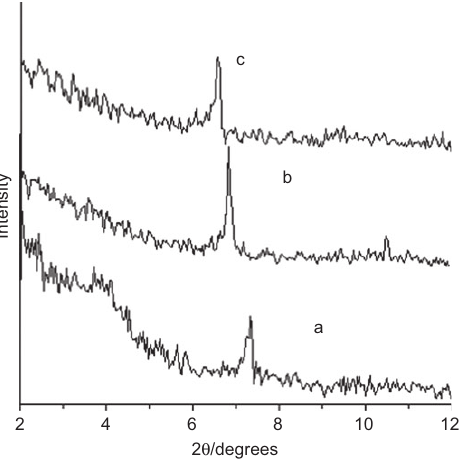
Figure 9 UV-vis absorption spectra of Ag-MMT-N and